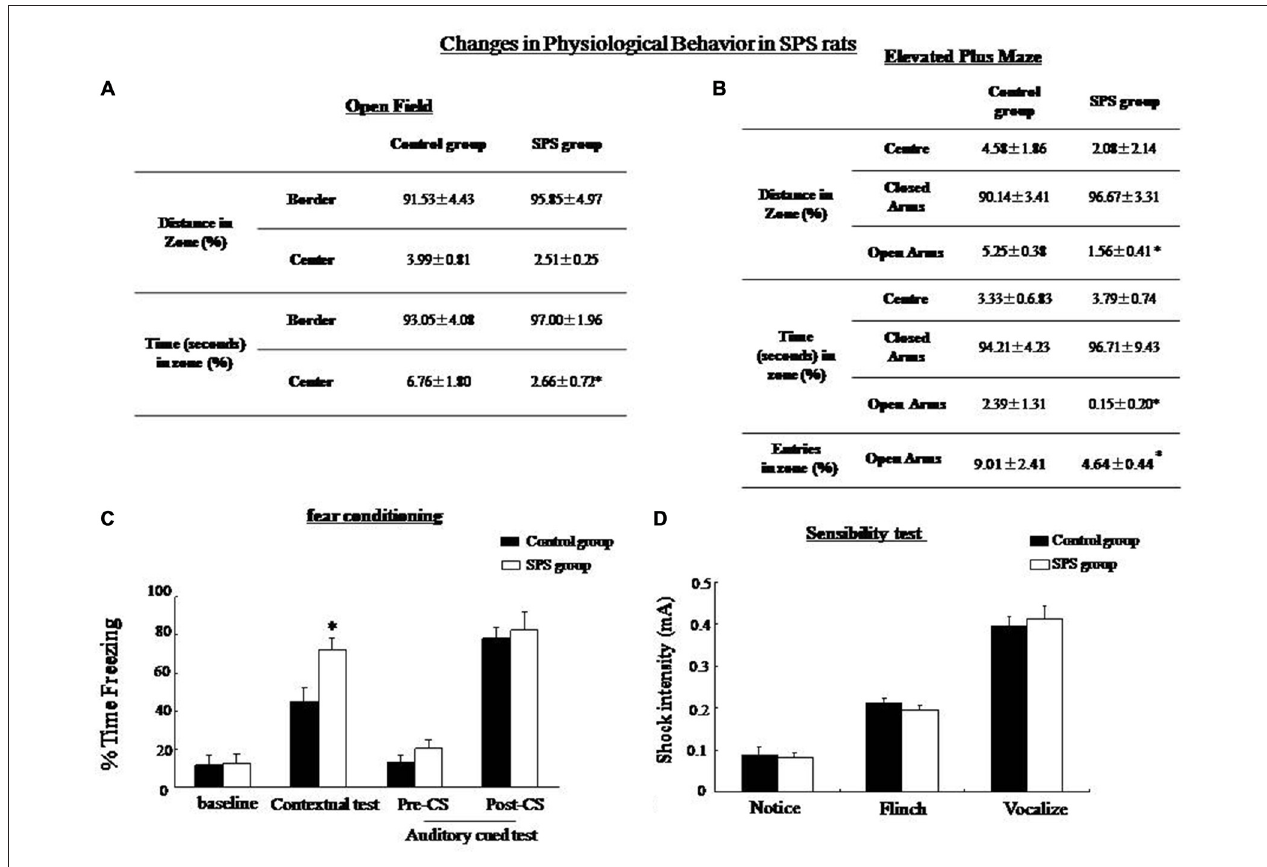
FIGURE 1 | Single prolonged stress (SPS) rats showed decreased exploratory behavior in an open field (OF) test and an elevated plus maze. (A) OF test: SPS rats ( n = 10) spent less time in the center zone and showed less rearing compared with the control group ( n = 10). (B) Elevated plus maze: SPS rats spend shorter distances and spent less number/time in the open arms compared with control rats. (C) Conditioning test: the percentage of time spent freezing in contextual fear conditioning was significantly higher in the SPS rats than in the control rats ( ∗ P < 0.05 vs. the control group), but no difference in auditory cue memory between control and SPS groups. (D) Sensibility test to the foot-shock, no significant difference in minimum current strength which induced notice, flinch and vocalize was found between control and SPS rats.